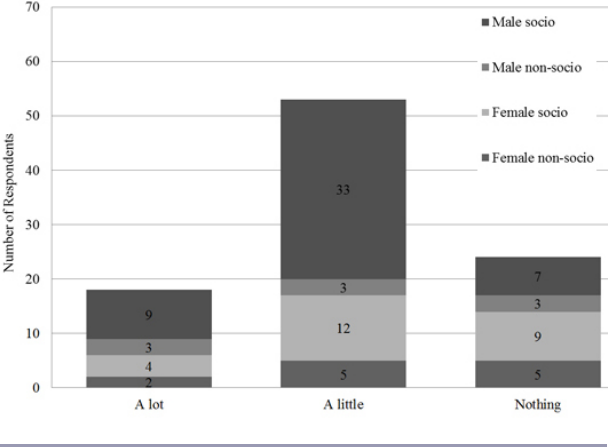
Fig. 3 . Perceived level of information about the Socio Bosque incentives ( N =